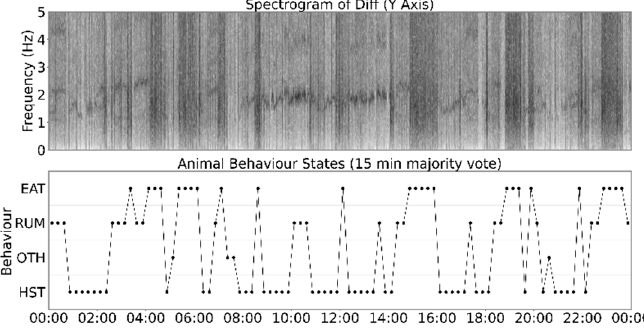
Figure 8. Spectrogram and 15 min aggregate of behaviour classification.